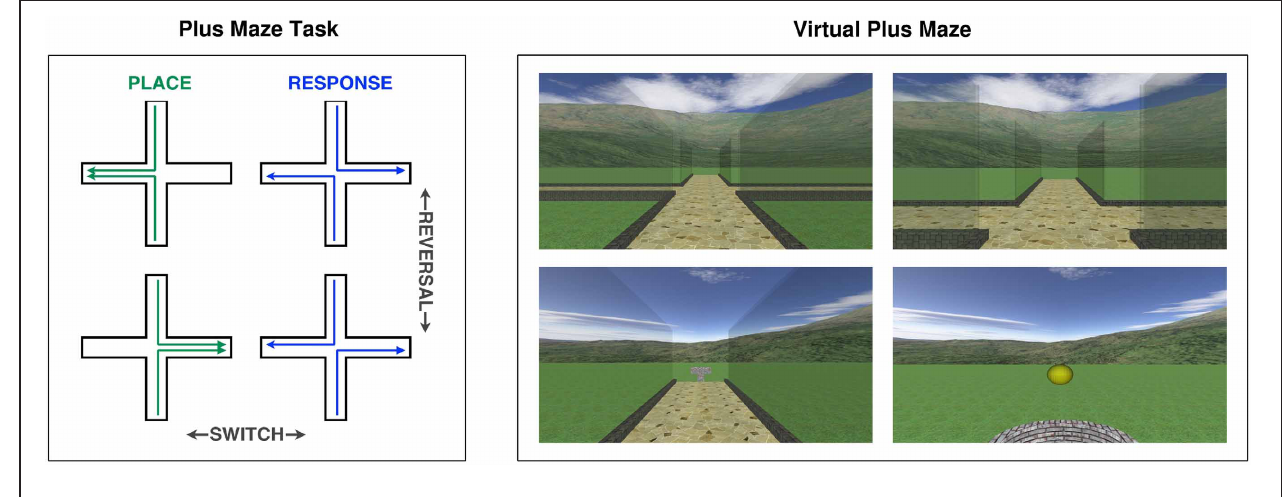
FIGURE 1 | Left: Diagrammatic representation of the plus maze task, illustrating place and response strategies, and switch and reversal change types. Right: Screen images captured during